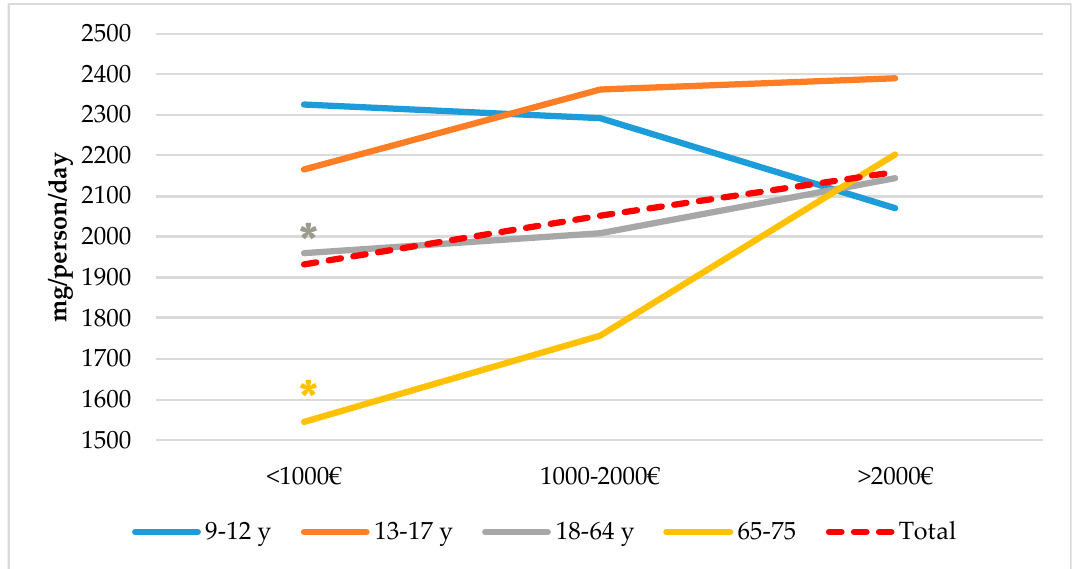
Figure 3. Sodium intake from total population by habitat size from the ANIBES study population.